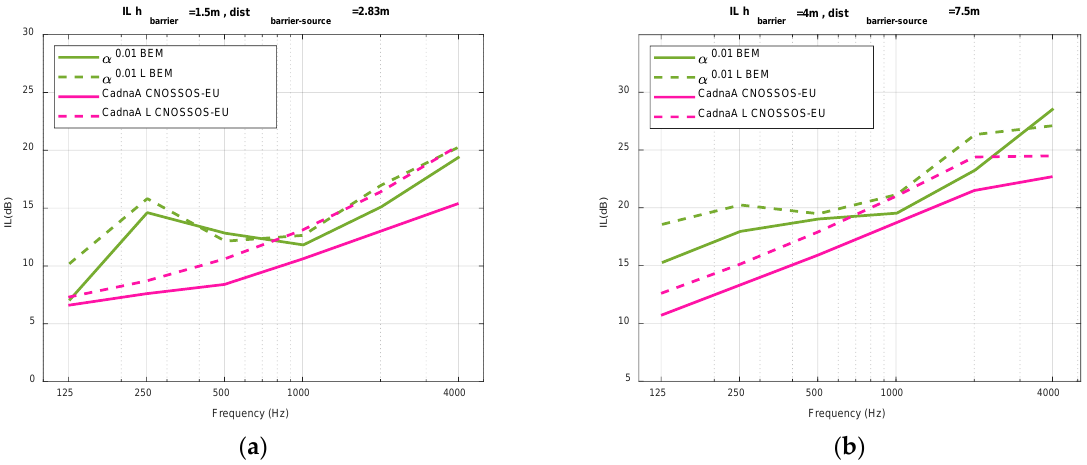
Figure 15. Insertion loss curves calculated with Cadna A CNOSSOS-EU and BEM methodologies. Comparisons for reflective barriers, with heights of: ( a ) 1.5 m and ( b ) 4 m.